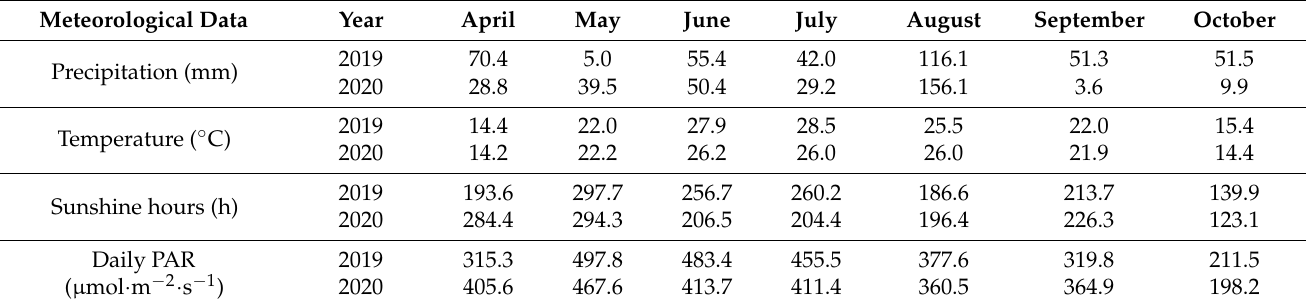
Table 1. Meteorological information of the cotton growth period in the experimental site.